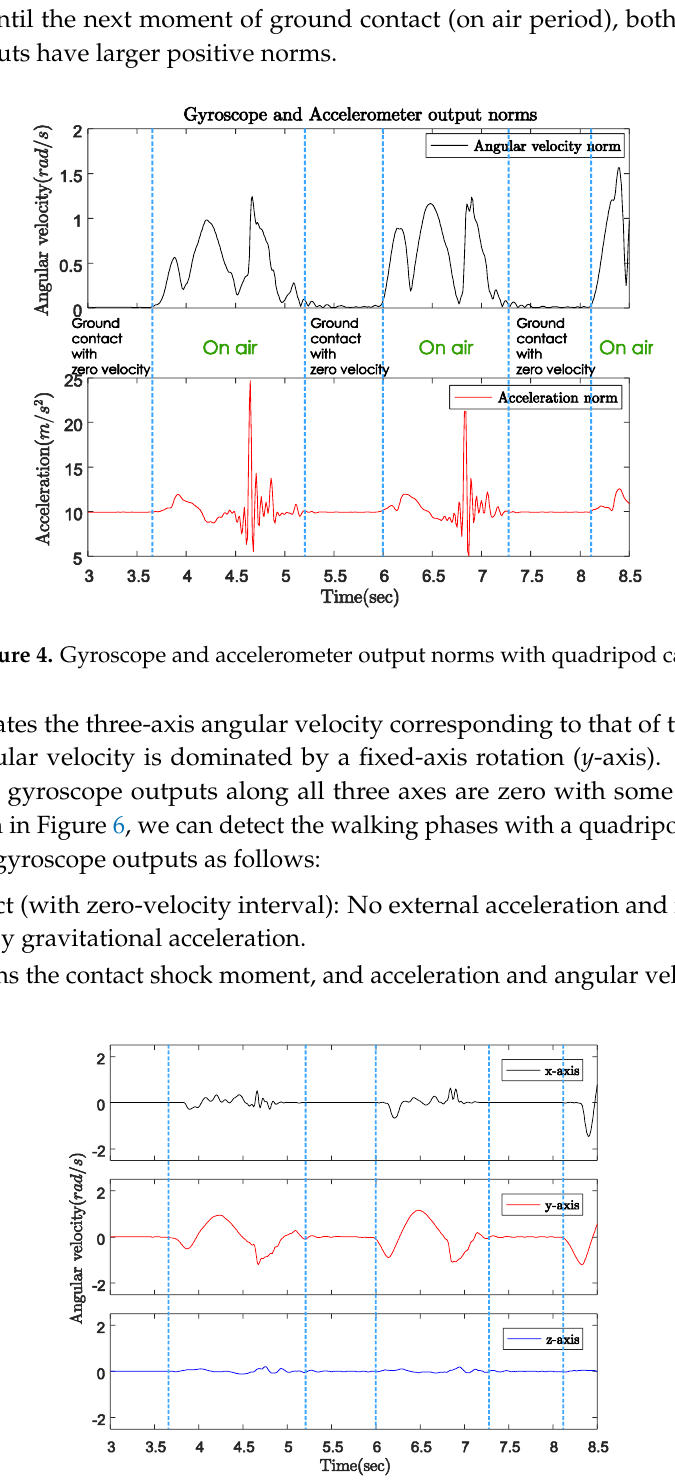
Figure 5. Three-axis angular velocity from gyroscope output with quadripod cane.